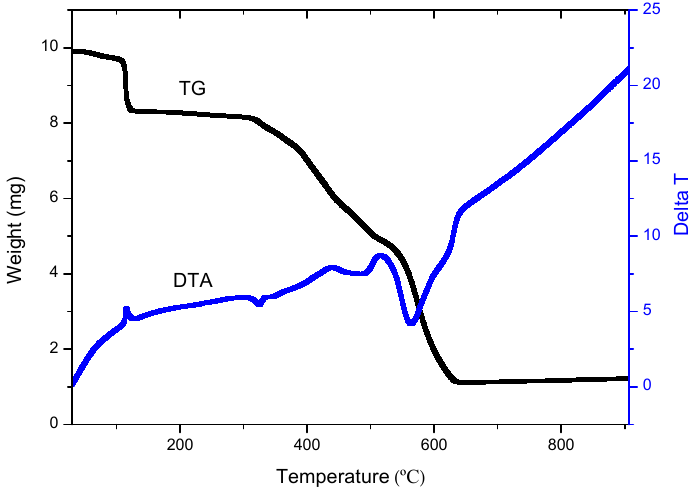
Figure 9. The TG-DTA curves of compound 2 .